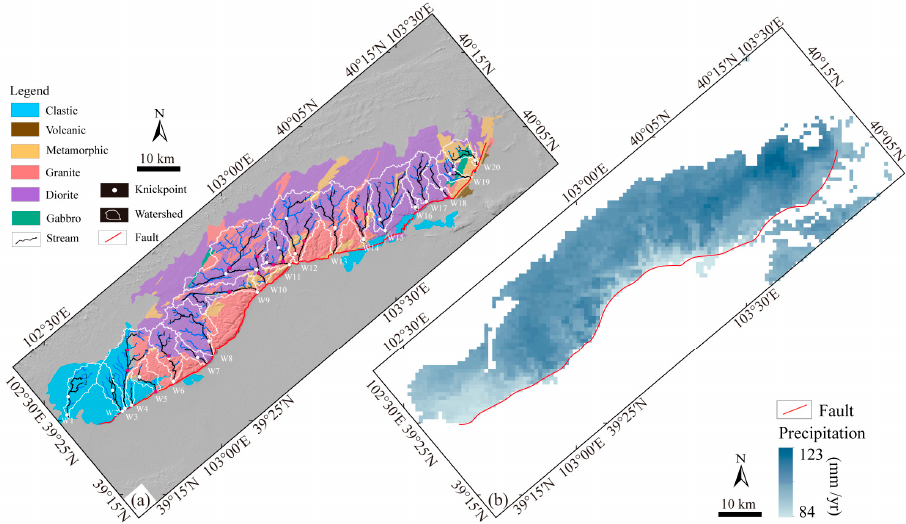
Figure 11. Lithology and precipitation maps of Yabrai Shan. ( a ) Distribution of the lithology, water- sheds(W), streams and knickpoints. ( b ) Regional precipitation of Yabrai Shan. The white, blue, black and red lines represent the watershed, streams, streams used in the river longitudinal profile analysis and the Yabrai range-front fault, respectively. The red points in ( a ) were the knickpoints on the lithological boundary. Precipitation data derived from http://www.worldclim.org/ (15 November 2021).